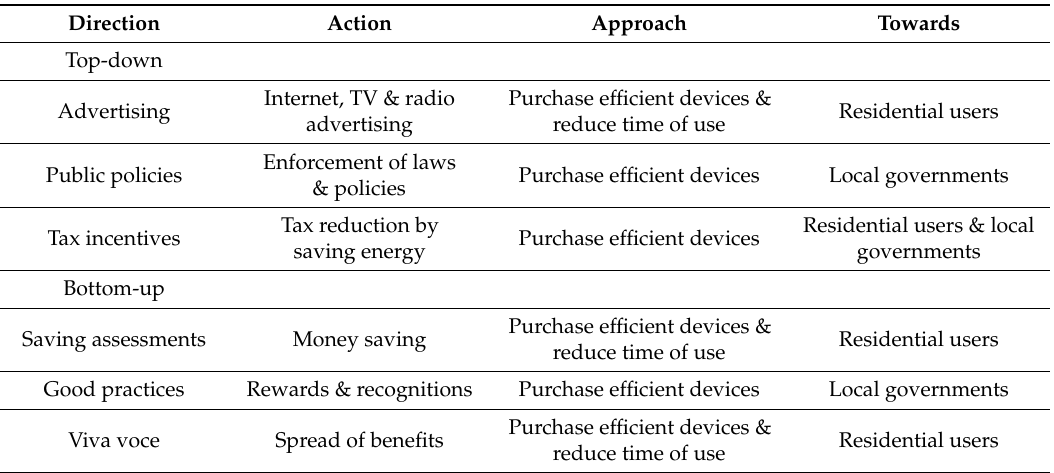
Table 9. Main actions for the top-down and bottom-up national strategy for energy saving onto the Mexican residential